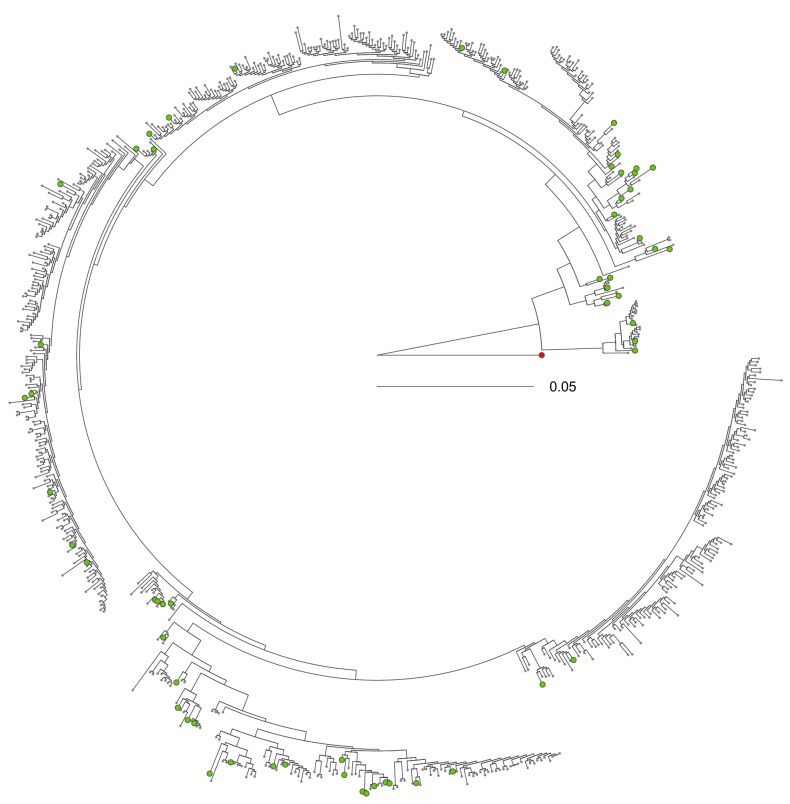
Maximum likelihood phylogenetic tree indicating the evolutionary relationships between the 59 MSV-A isolates selected in this study and all other available MSV-A isolates.Selected MSV-A isolates are highlighted with green tip circles and the MSV-B outgroup is represented with a red tip circle.